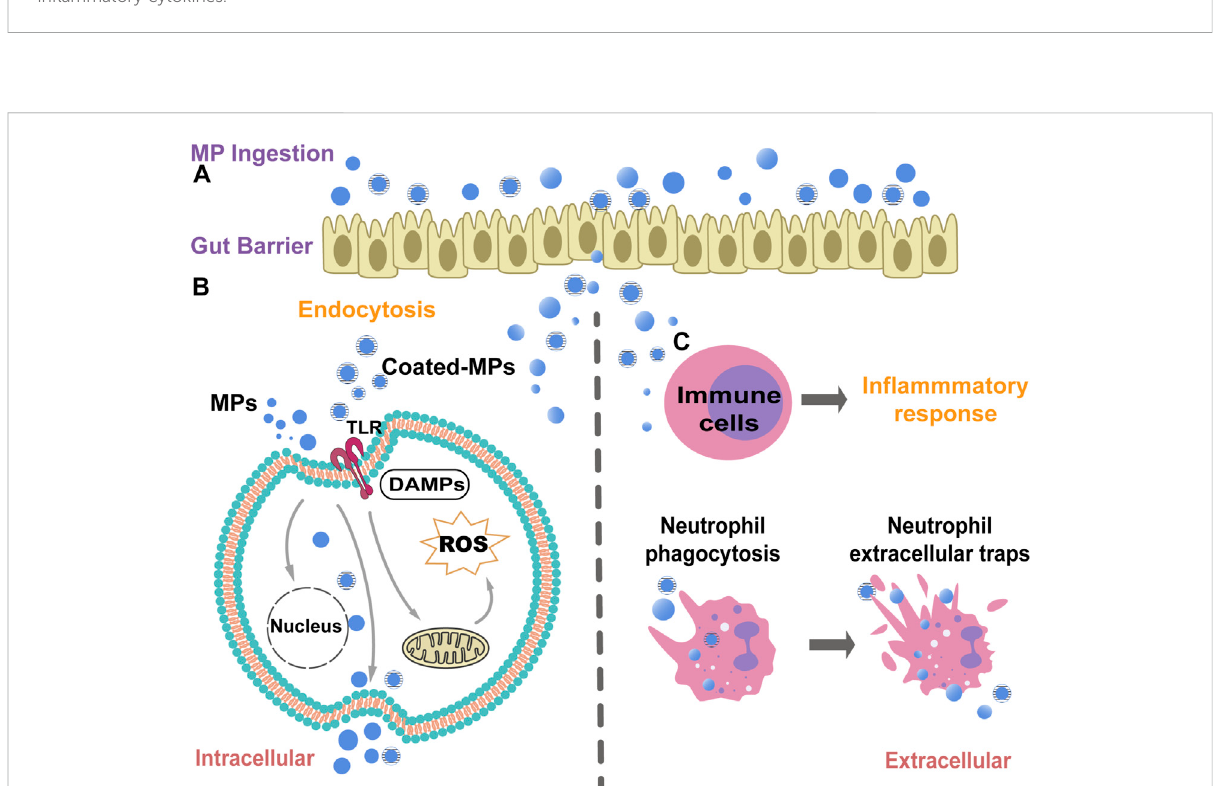
FIGURE 4 A schematic diagram illustrate the potential biological mechanisms of MPs cytotoxicity and immunotoxicity. (A) . MPs can attach to the plasma membrane and in fi ltrate through the gut barrier after ingestion. (B) . MPs can be taken up through endocytosis to affect the potential signaling pathways induction. MPs can induce intracellular ROS and oxidative stress by affecting the mitochondria function, thus fi nally triggering cellular apoptosis. The MPs could be released out from cells after cell lysis. The coated-MPs may induce the immune responses through the activation of pathogen recognition receptors (PRRs), e.g. toll-like receptors (TLRs). (C) . The MPs can trigger in fl ammatory responses after MPs interaction and endocytosis in macrophages and neutrophils. However, massive MPs endocytosis can cause the cell death of neutrophils, which in turn induces the neutrophil extracellular traps (NETs) to capture and restain the MPs in